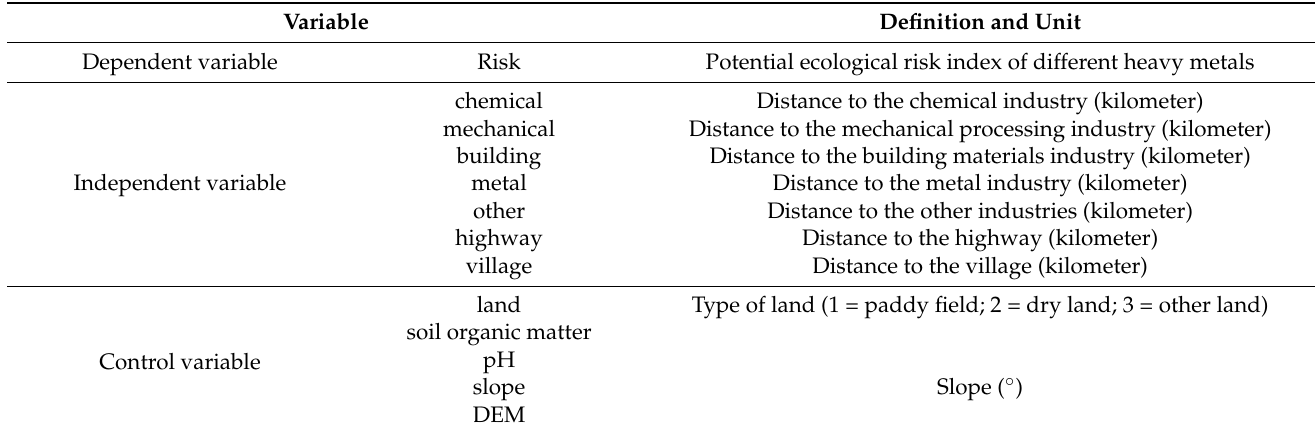
Table 5. Definition and descriptive statistics of variables.